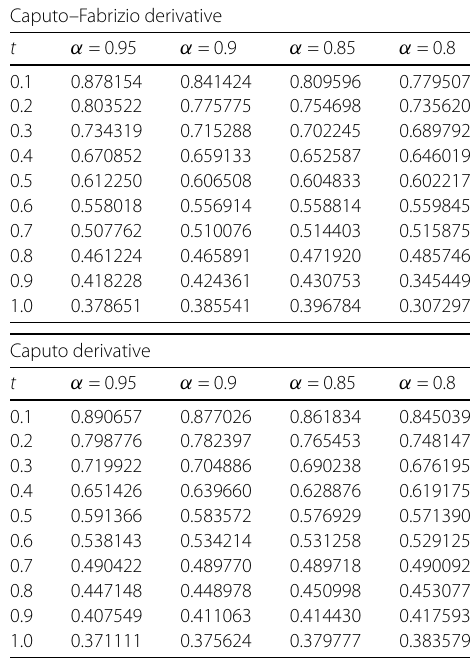
Table 6 Numerical comparison of RK solutions of Example